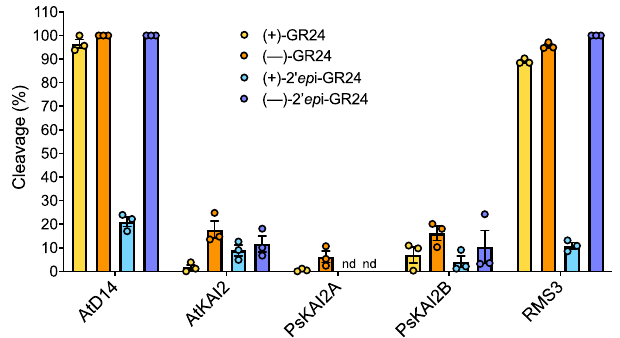
Fig. 5 Comparative enzymatic activity of AtD14, AtKAI2, RMS3, PsKAI2A and PsKAI2B proteins with GR24 isomers. UPLC-UV (260 nm) analysis showing the formation of the ABC tricycle from GR24 isomers. The enzymes (10 μ M) hydrolysis activity was monitored after incubation with 10 μ M ( + )-GR24 (yellow), ( – )-GR24 (orange), ( + )- 2 ’ -epi -GR24 (blue), or ( – )- 2 ’ -epi -GR24 (purple). The indicated percentage corresponds to the hydrolysis rate calculated from the remaining GR24 isomer, quanti fi ed in comparison with indanol as an internal standard. Data are means± SE ( n = 3). nd = no cleavage